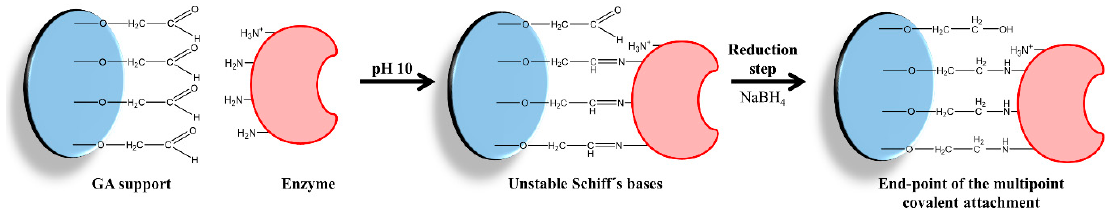
Figure 1. Schematic representation of the protein immobilization on activated glyoxyl supports.